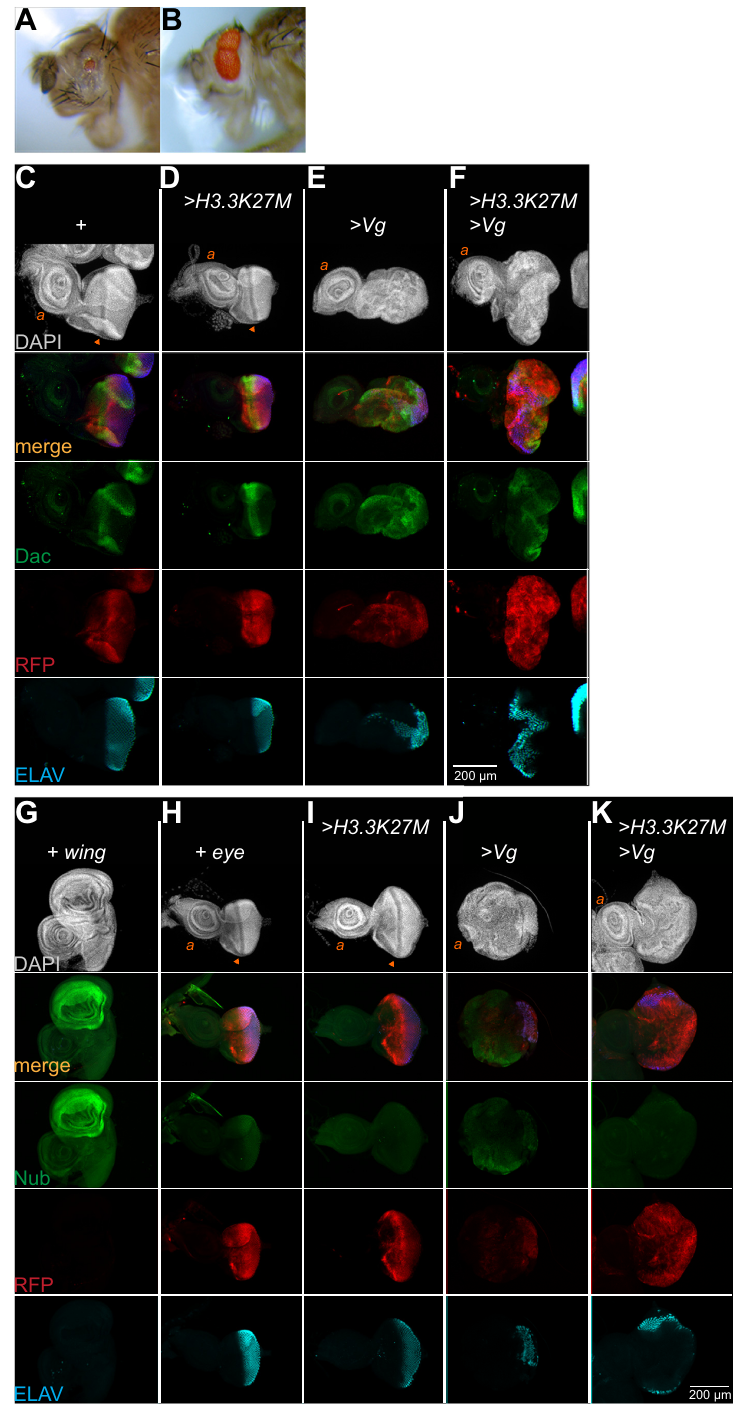
Fig 4. Tissue-specific gene expression changes during direct reprogramming. ( A ) Side view of a vg CL7A mutant adult with eyGAL -induced Vg production in the eye. Eye size is reduced, but not transformed into a wing. ( B ) Side view of a vg U /+ head with eyGAL -induced H3.3K27M and Vg co-production in the eye. The eye is convoluted but reduced in size instead of overgrown. ( C-F ) Eye-antennal discs with eyGAL -induced production of RFP, H3.3K27M and Vg and immunostained for the eye-specific Dac protein and for ELAV. Neither Vg nor H3.3K27M production prevent Dac expression, although these discs are disorganized. The wildtype ‘+’ strain was eyGAL4 > UASRFP/CyO . ( G-K ) Wildtype (‘+’, eyGAL4 > UASRFP/CyO ) wing imaginal discs ( G ) and eye-antennal discs with eyGAL